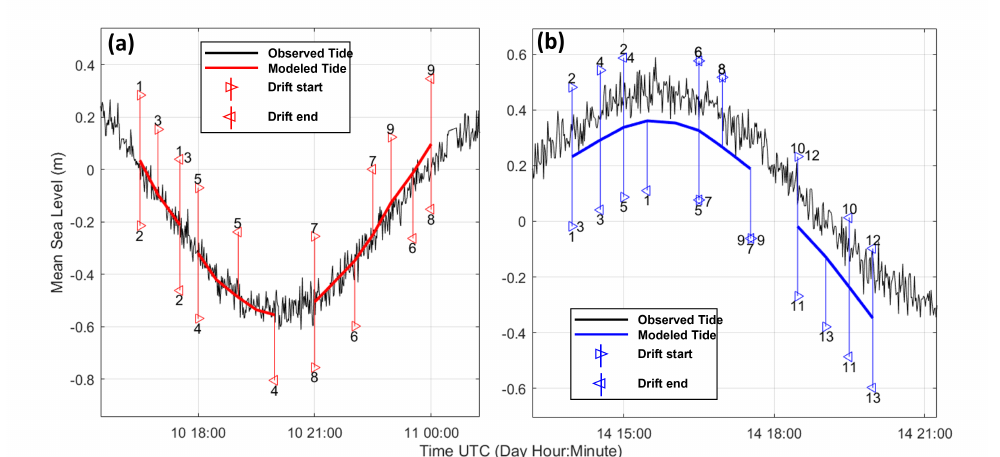
Figure 9. Drifter measurement periods during 10 September 2011 ( a ) and 14 September 2011 ( b